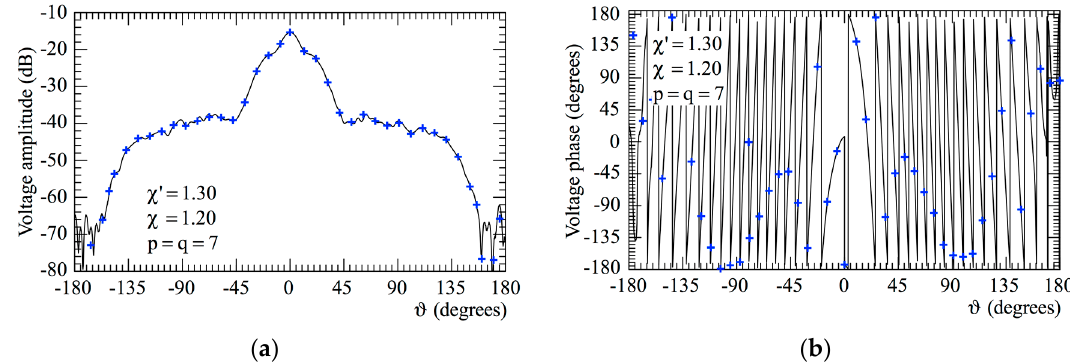
Figure 7. r V on the meridian at ϕ = 0 ――― reference. + + + + interpolated from the non-redundant measurements: ( a ) amplitude; ( b ) phase.